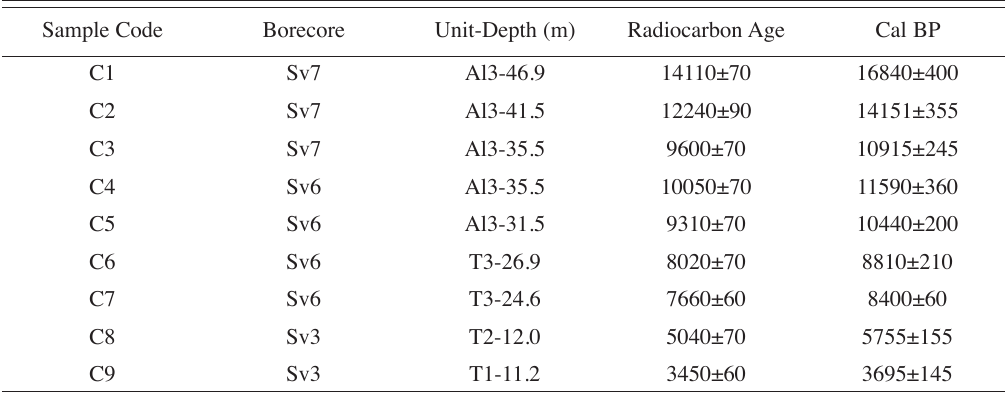
Table I. Measured and dendrochronologically calibrated 14 C age of samples collected in the boreholes. Sample